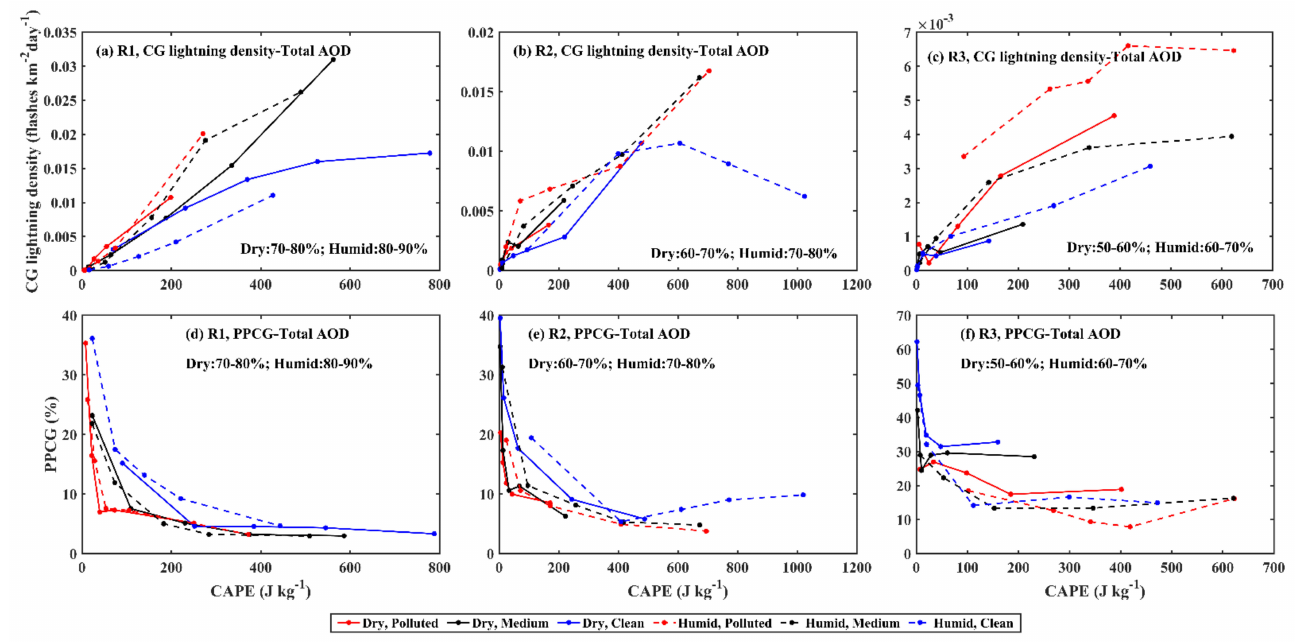
Figure 9. ( a )~( c ) Mean CG lightning density (unit: flashes km − 2 day − 1 ) and ( d )~( f ) PPCG (%) as a function of CAPE for clean (blue), medium (black), and polluted (red) conditions for three study regions during 2010–2018. These relationships are investigated under two SRH conditions in each study region. The selected SRH ranges in R1 are 70–80% and 80–90%, while that in R2 are 60–70% and 70–80%, and in R3 are 50–60% and 60–70%. The clean, medium, and polluted conditions are defined according to total AOD. Data from all seasons are included. The data of CAPE and SRH are derived from ERA5, and AOD data are derived from